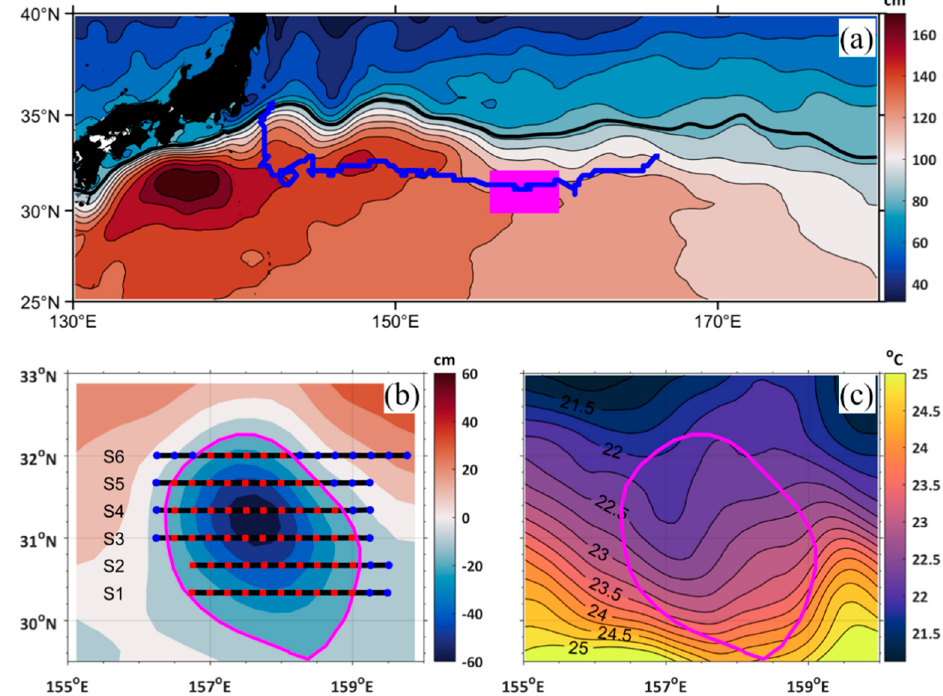
Figure 1. Surface characteristics. ( a ) Mean dynamic topography (MDT) in the northwestern North Pacific Ocean. The mean Kuroshio Extension axis is represented as bold black line, which is 120 cm of MDT. The blue line shows the eddy movement trajectory. The overlaid magenta rectangle is the study area (156.25–157.75 ◦ E, 30.33–32 ◦ N). ( b ) Sea level anomaly (SLA) and survey stations. Shaded areas indicate the SLA and the magenta line is the − 0.1 m contour of SLA, which indicates the boundary of the cyclonic eddy. The black lines are the cruising tracks, from south to north named S1, S2, S3, S4, S5 and S6. The squares overlaid on the tracks are the stations with Expendable conductivity–temperature–depth (XCTD) probes deployed. The red and blue squares indicate the stations inside and outside the eddy based on the eddy boundary. ( c ) Sea surface temperature observed by the satellite. The magenta line is the boundary as the same in ( b